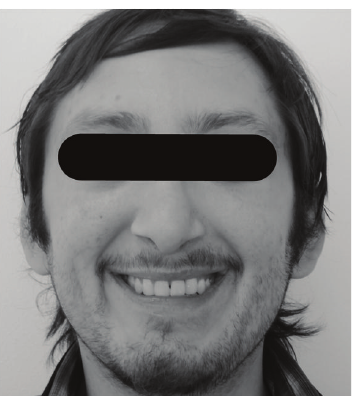
Figure 6: Smile picture after a two-year followup. There is a har- monic smile and the aesthetic remodeled canines look naturally as lateral